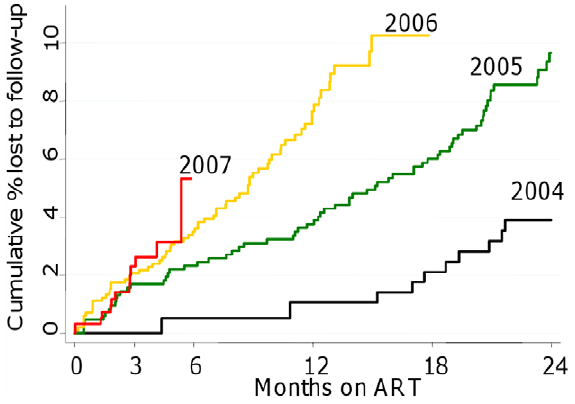
Figure 4. Cumulative probability of true LTF by year of initiation on ART. Weighted Kaplan-Meier estimates of true LTF by year of initiation on ART. True LTF increased and occurred earlier with each calendar year, as enrolment on ART